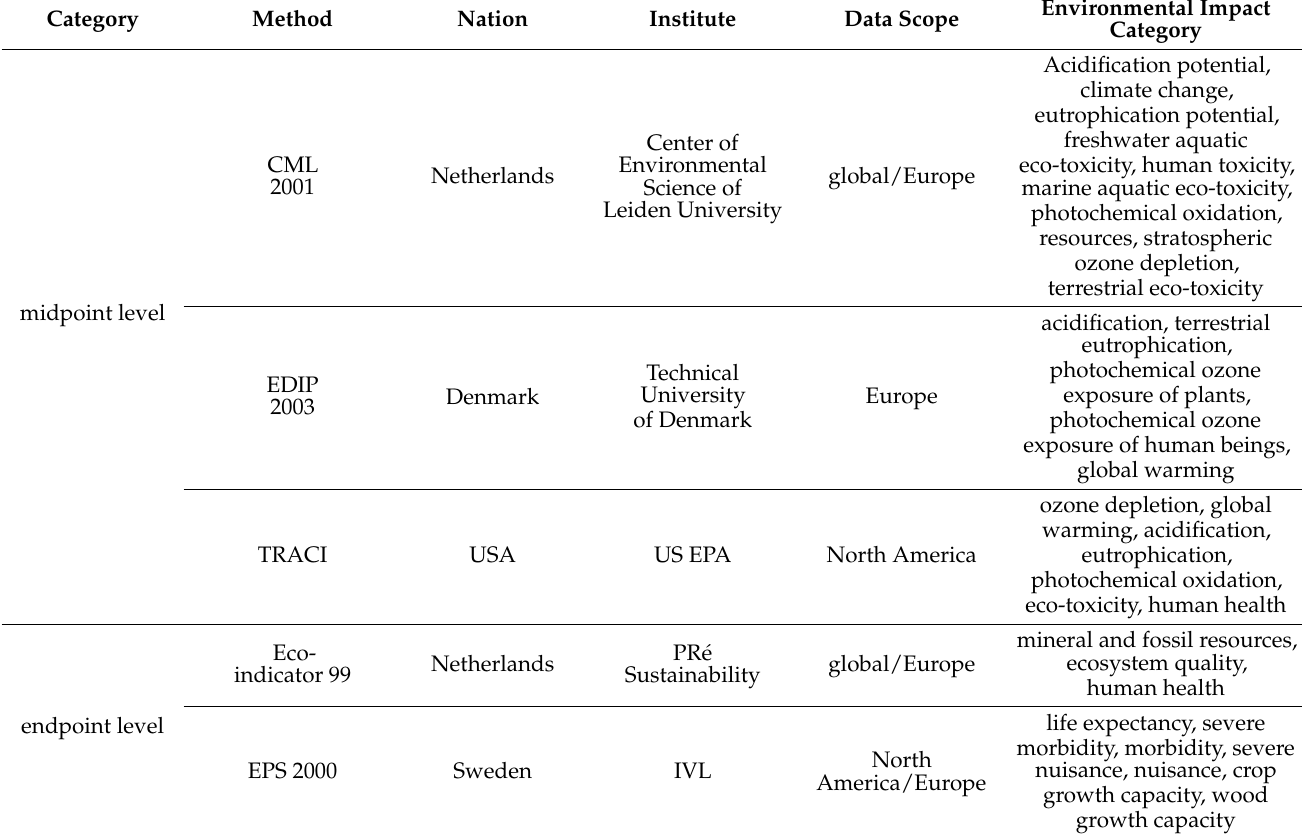
Table 1. Life cycle impact assessment methods